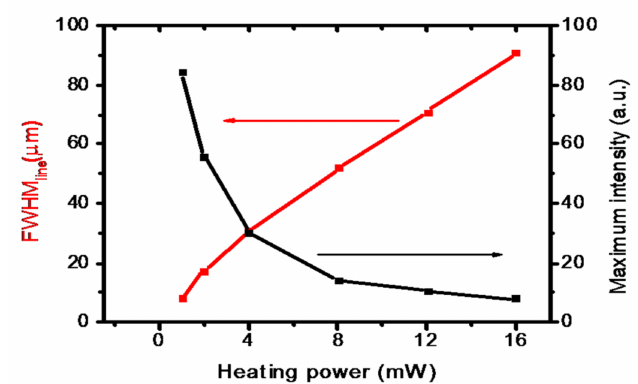
Figure 7. Focal line length (FWHM line ) and maximum on-axis intensity vs. the heating power P h for λ 2 = 405 nm. The focal length of the focusing lens is 2.6 mm. The increase in FWHM line is accompanied by a reduction in the intensity. See text for